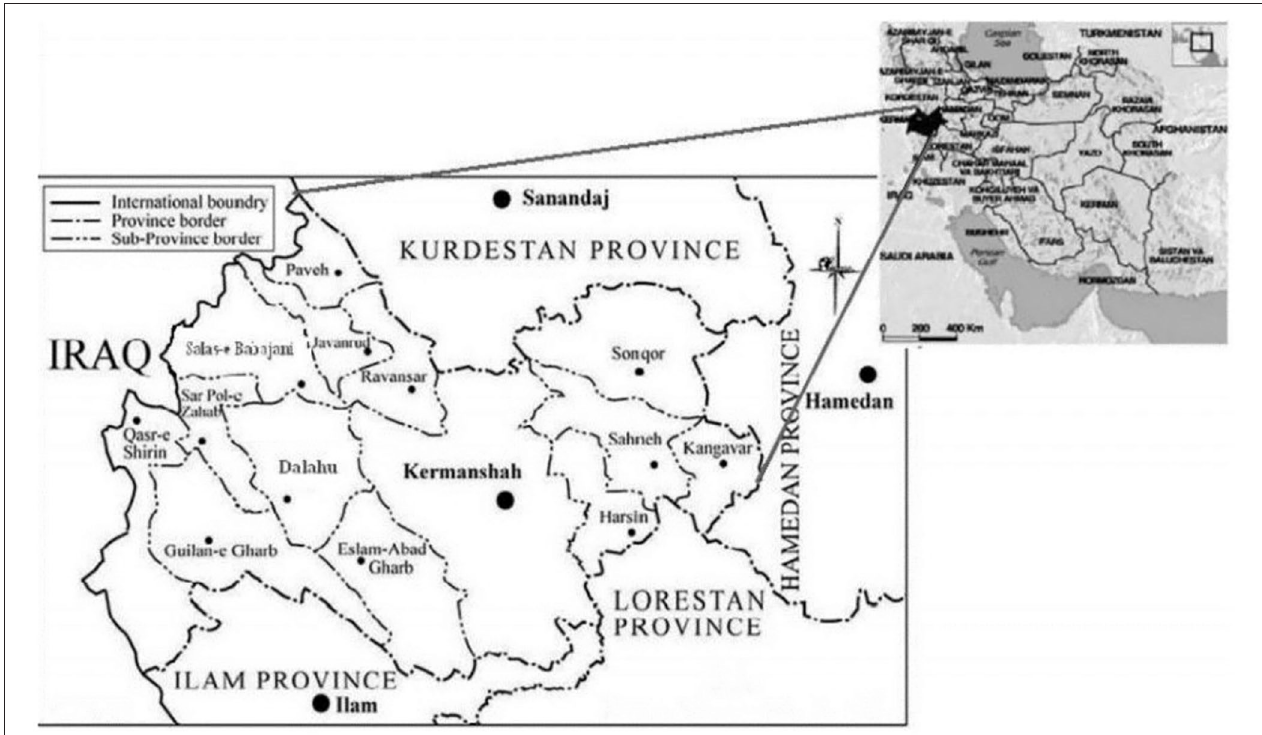
FIGURE 1 | The study area; Kermanshah province, which is located in Western